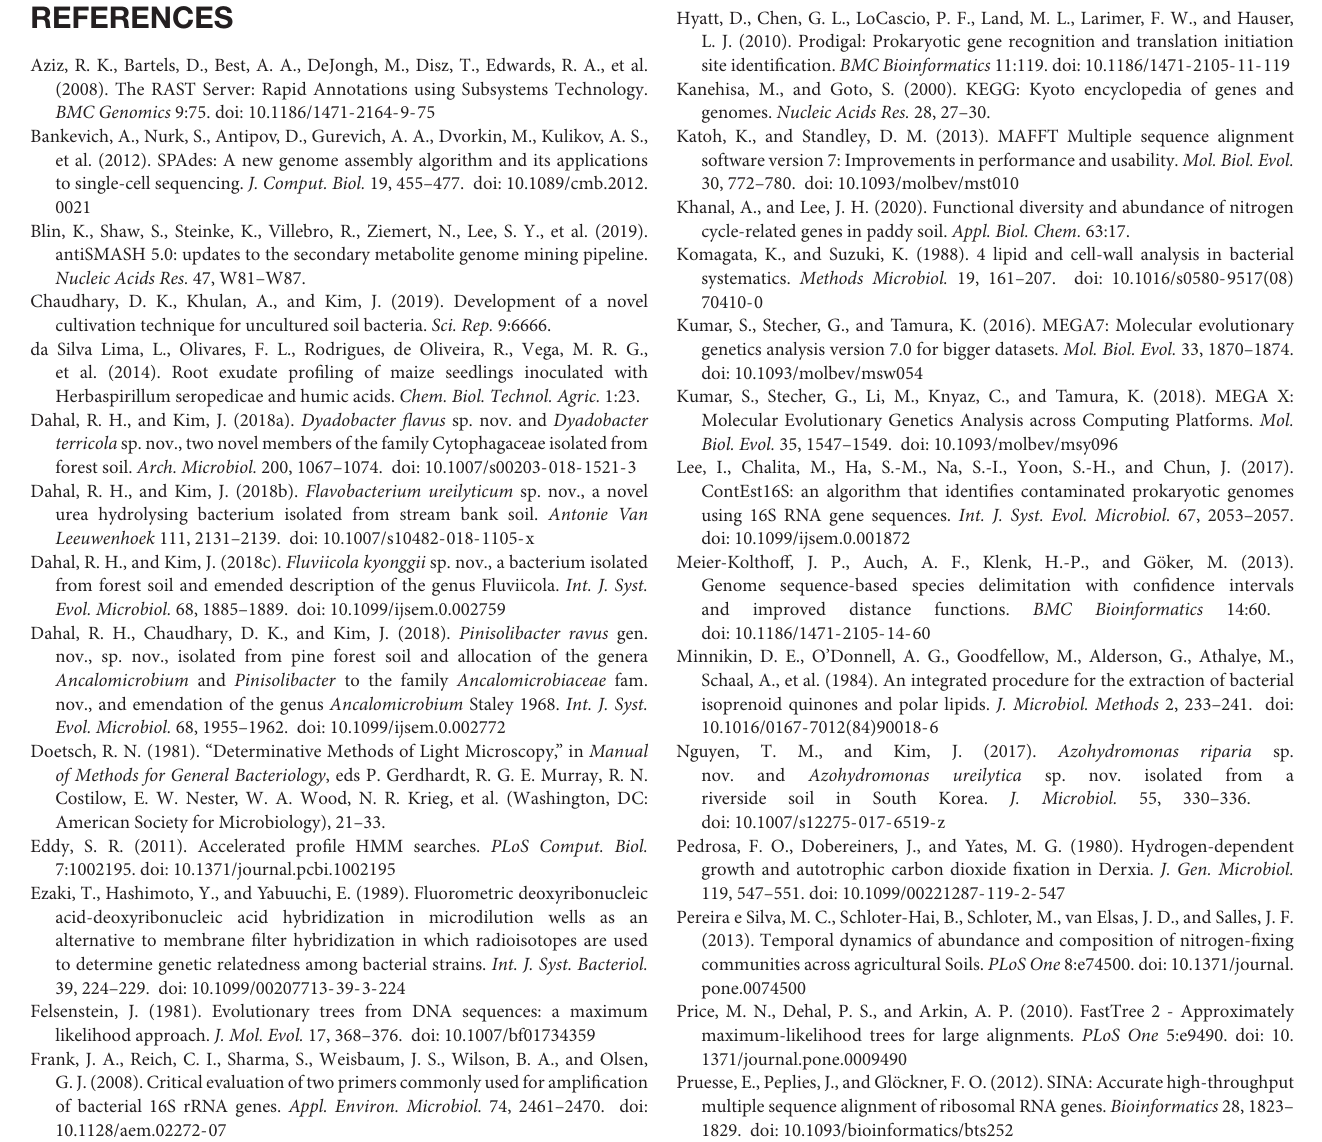
Supplementary Figure 1 | Neighbor–joining tree based on 16S rRNA gene sequences showing the phylogenetic position of strain G-1-1-14 T . Supplementary Figure 2 | Neighbor–joining tree based on 16S rRNA gene sequences showing the phylogenetic position of strain G-1-1-14 T . Supplementary Figure 3 | Maximum–parsimony tree based on 16S rRNA gene sequences showing the phylogenetic position of strain G-1-1-14 T . Supplementary Figure 4 | MLSA (Multilocus sequence analyses) tree based on recA genes showing the phylogenetic position of strain G-1-1-14 T among the closest phylogenetic members. Supplementary Figure 5 | MLSA (Multilocus sequence analyses) tree based on rpoB genes showing the phylogenetic position of strain G-1-1-14 T among the closest phylogenetic members. Supplementary Figure 6 | Transmission electron microscopic image of strain G-1-1-14 T grown on R2A agar at 28 ◦ C for 7 days.